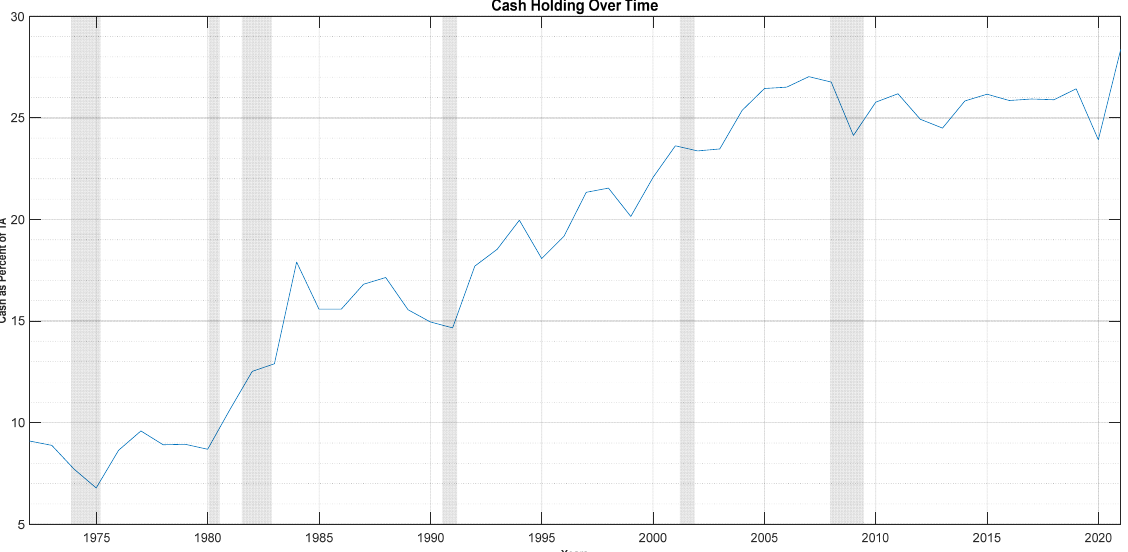
Figure 1. Average cash ratio over time. The line represents the annual average ratio of cash and short-term investment to total assets since 1971. The average cash to total assets ratio for each year is defined as the cross-sectional average of individual firms’ cash to total book value of assets. The shaded region represents the NBER-defined recessions for the U.S. economy.